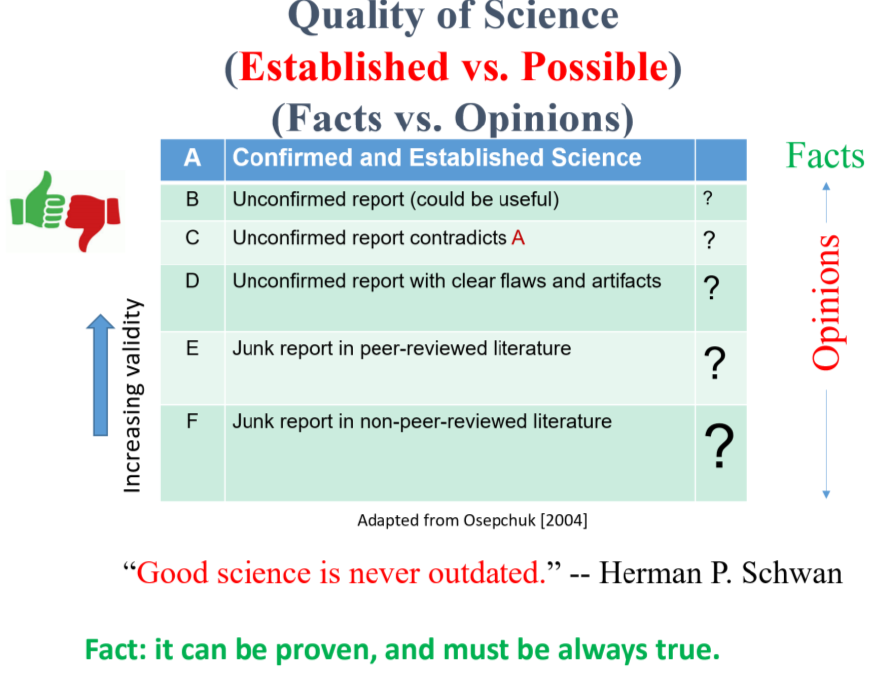
Figure 1. Center of the controversy: conflict between facts and opinions.